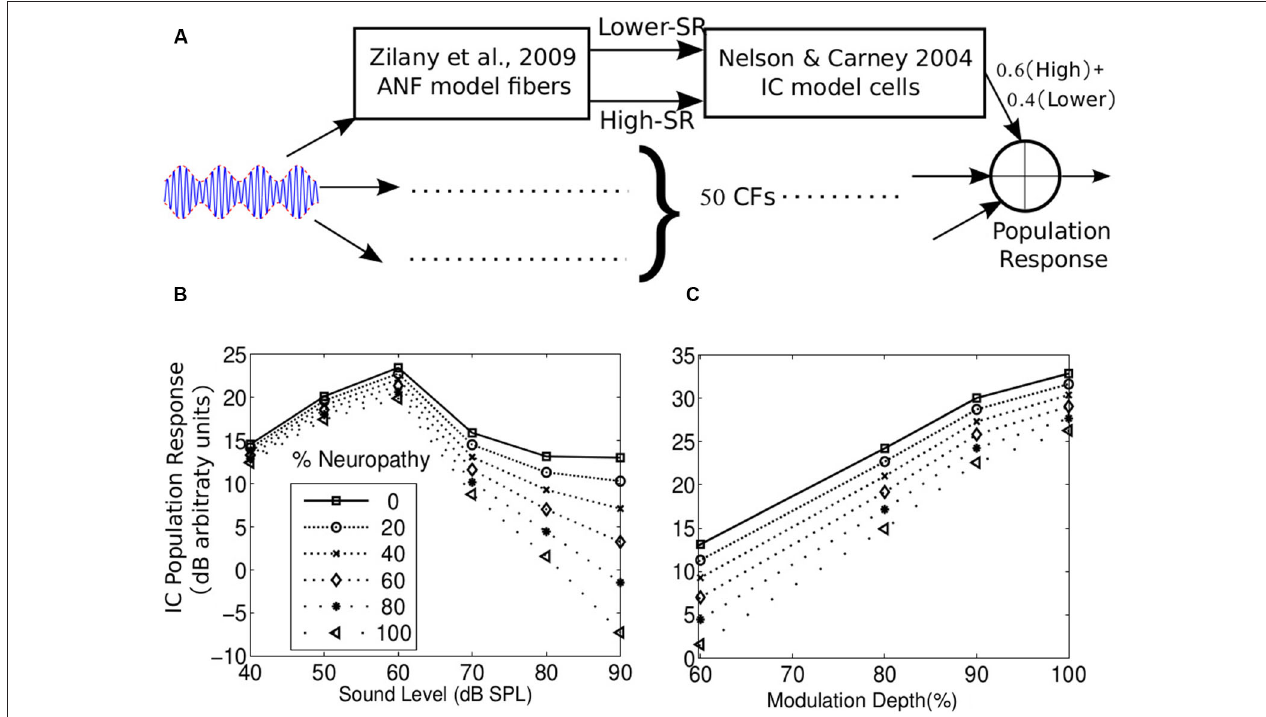
noise with a notch centered around 4 kHz and 800 Hz wide on each side. The SNR was fixed at 20 dB (broadband RMS) at all levels. The differences between the levels of neuropathy are most accentuated in the population response at higher stimulus levels. This also suggests that slopes of the level curve at high levels may reflect the level of neuropathy. (C) Population response as a function of modulation depth for different levels of neuropathy for an 80 dB SPL SAM tone in notched noise (SNR = 20 dB broadband RMS). The differences between the levels of neuropathy are more evident for smaller modulation depths. In addition, this suggests that the slope of the population response strength as a function of modulation depth may be sensitive to the level of